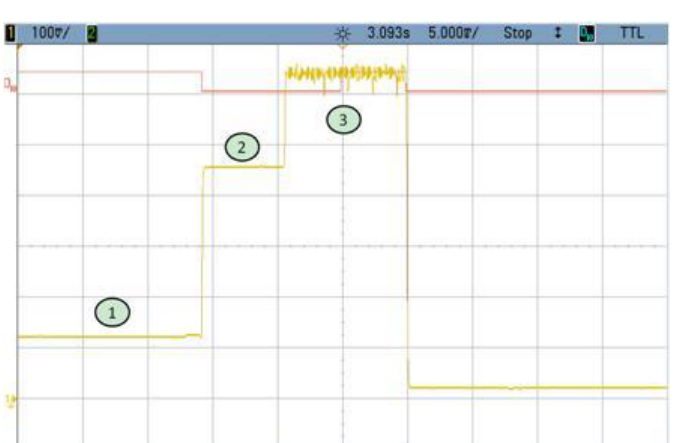
Figure 12. Test 4 SHA1